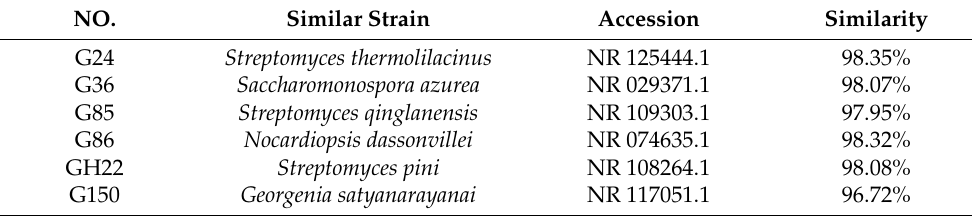
Table 5. Potential novel species based on 16S rRNA gene sequence analysis.